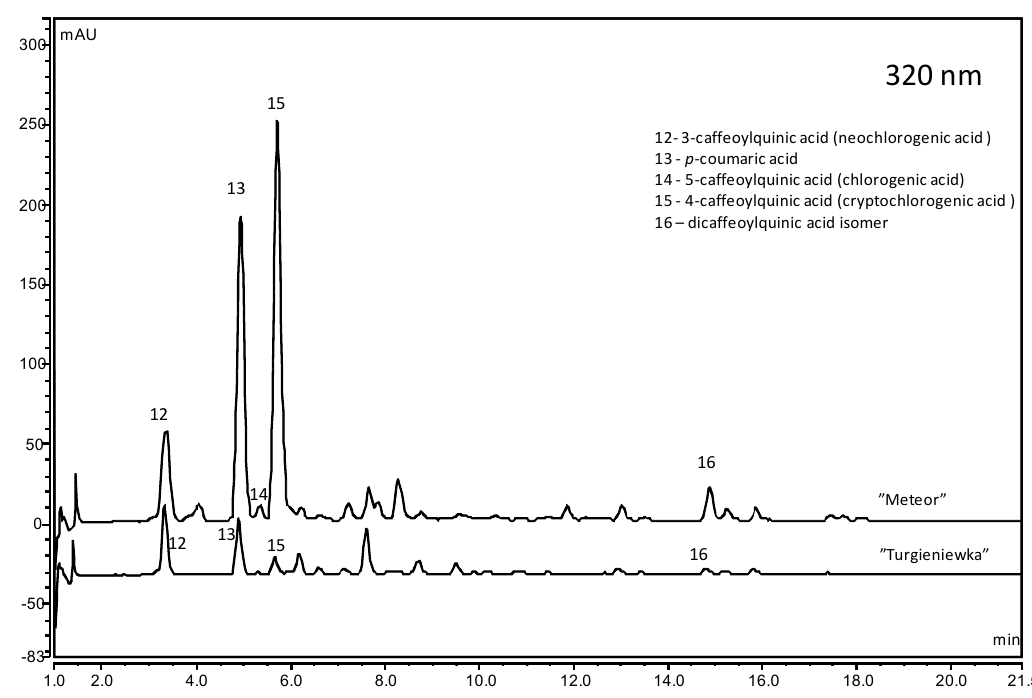
Figure 3. Chromatograms (320 nm) of sour cherry fruit cultivars with the highest and the lowest content of phenolic